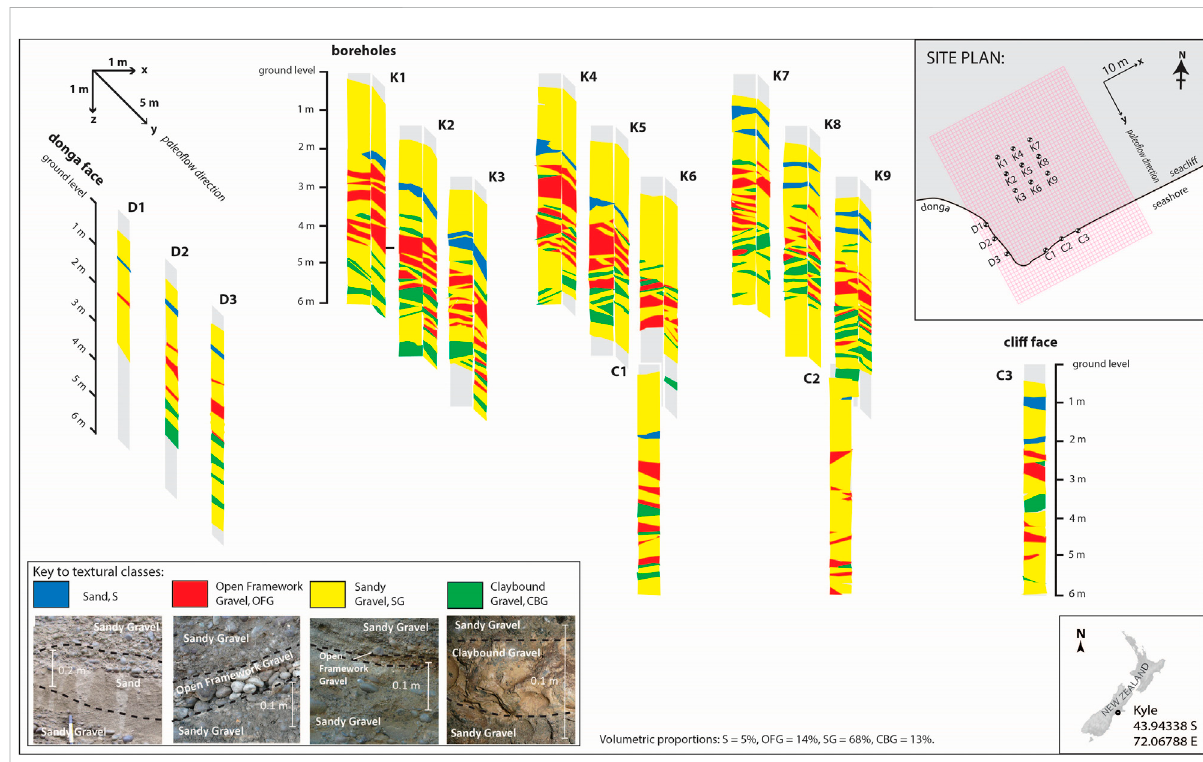
FIGURE 1 Box plot map of the Kyle site showing the spatial distribution of the four main lithological categories (textural classes), as identi fi ed on cliff exposuresandboreholewalls.Sitelocation,andthemodeldomainandgridthatisusedinthegeostatisticalandgroundwatermodellinganalyses,are shown in inset of site plan. Representative photographic images of textural classes are included in the